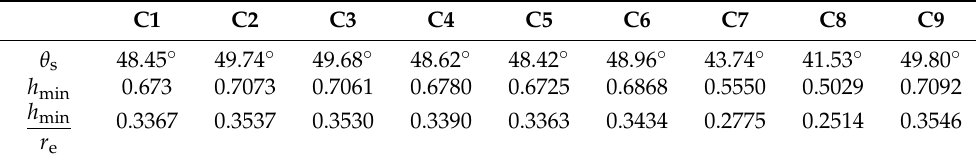
Table 4. Calibrated MUCT value.